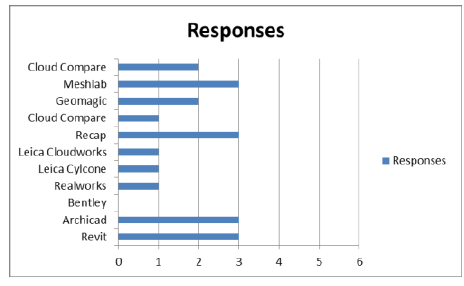
Figure 2: Software used in HBIM workflow